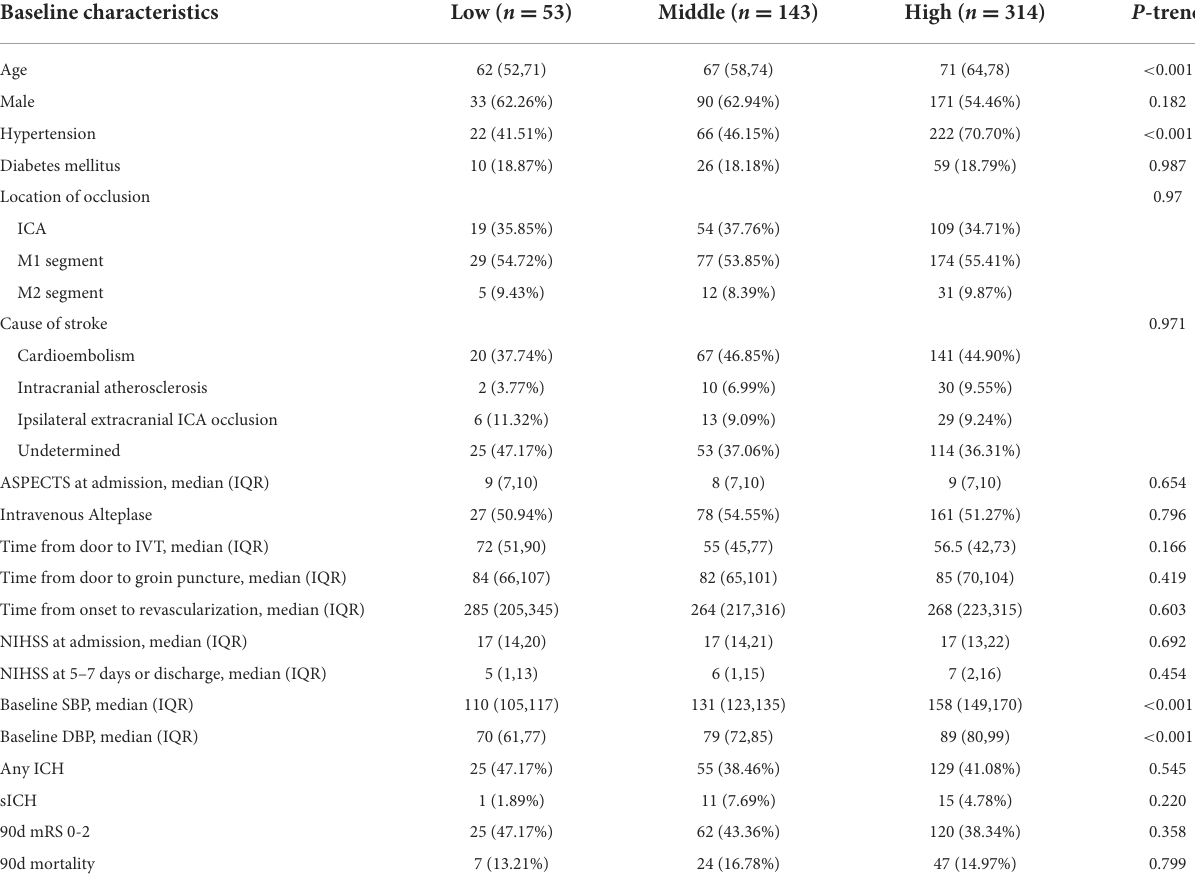
TABLE 1 Baseline characteristics of successfully revascularized